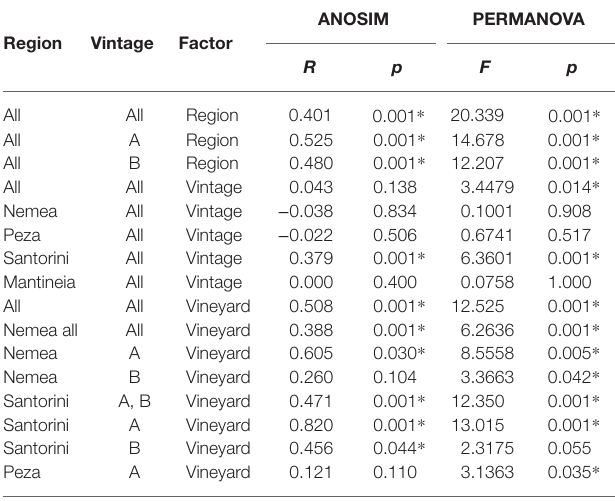
( Figure 3C ). Regions had non-intersecting circles suggesting that groups were significantly different. The species that strongly